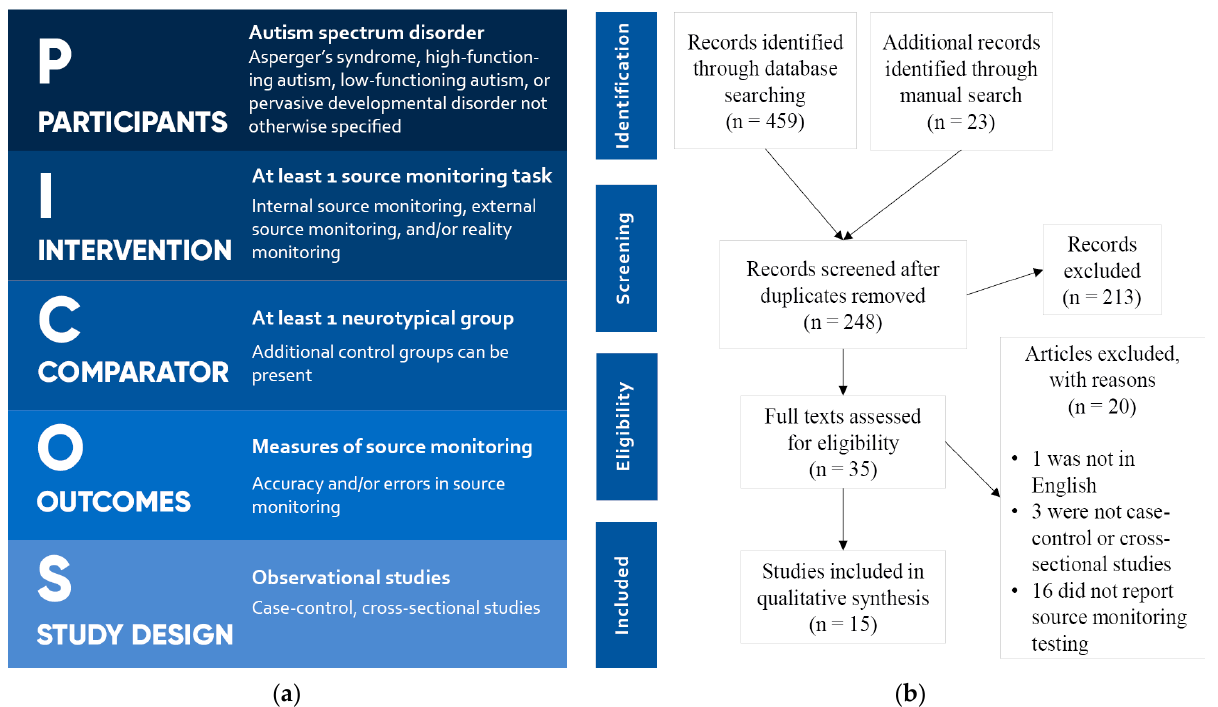
Figure 1. ( a ) PICOS criteria for study selection; ( b ) PRISMA flowchart.